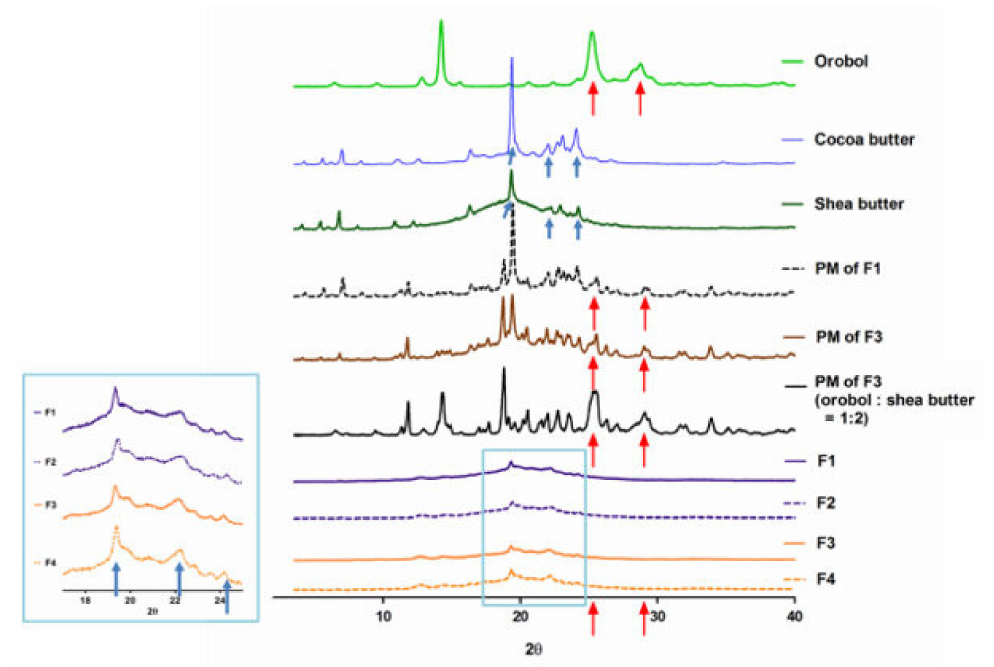
Figure 3. X-ray di ff raction patterns (relative intensity) of the orobol, solid lipids (i.e., cocoa butter and shea butter), physical mixtures (PMs) of F1 and F3, and lyophilized SLNs and NLCs formulations (F1 to F4). Crystalline peaks of the orobol are presented at 25.5 ◦ and 28.8 ◦ 2 θ (red arrows), while those of the lipids are presented at 19.3 ◦ , 22.1 ◦ , and 24.2 ◦ 2 θ (blue arrows).